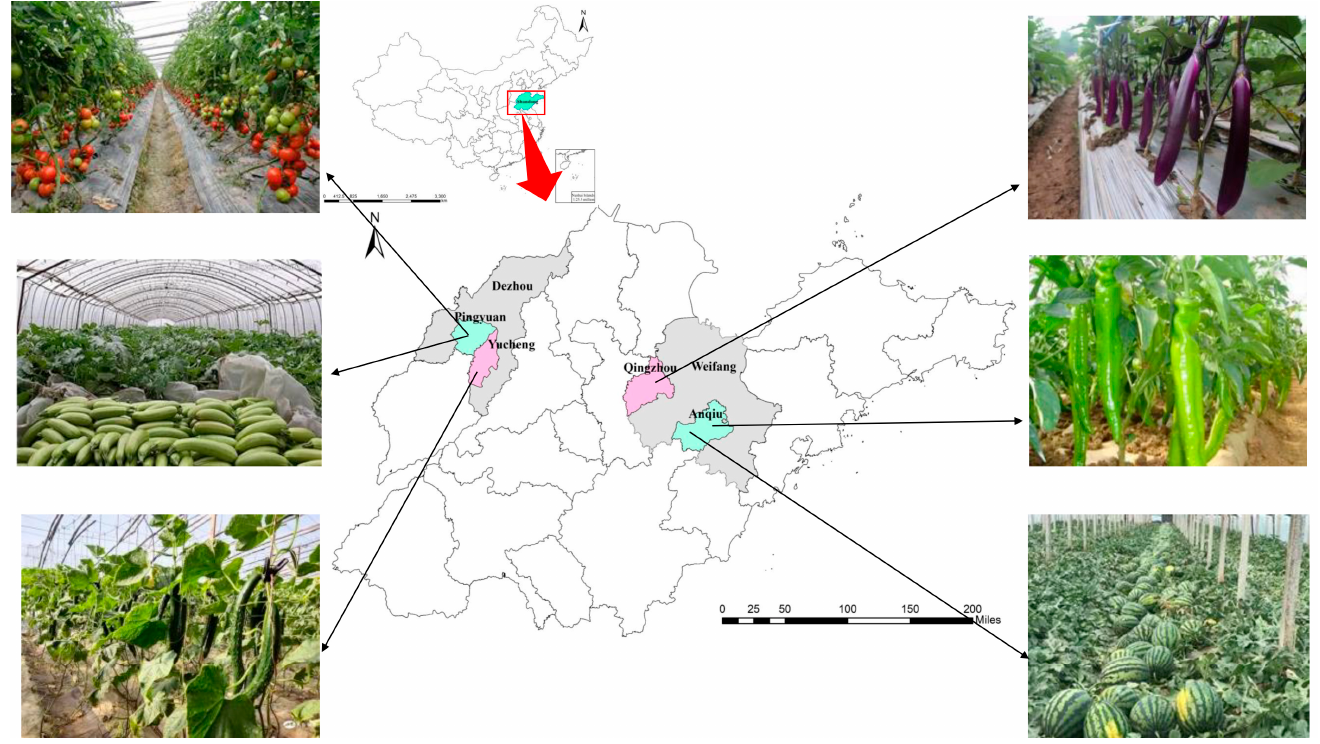
Figure 2. Location of study districts, Shandong, China.